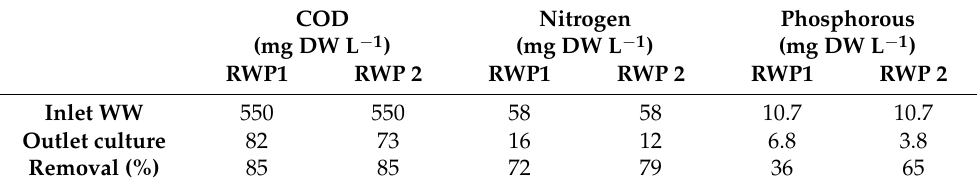
Table 1. Averaged composition of wastewater (COD—chemical oxygen demand, nitrogen, and phosphorous content) supplied to outdoor bioreactors RWP1 and RWP2 during the outdoor trial and nutrient removal rate. The WW (inlet) and microalgae culture (outlet) were supplied/harvested continuously over the day and then averaged samples were analyzed for bioreactors RWP1 and